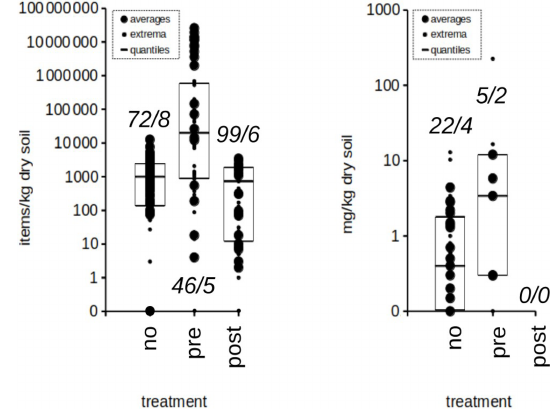
Figure 4. Quantities of MPs measured after density fractionation without the treatment of soil organic matter (SOM; no), with pre- treatment (pre) and post-treatment (post). Big dots mark median and mean concentrations measured in worldwide field experiments, small dots are the related extreme values or standard deviations, and strong horizontal lines are the overall medians and narrow lines are the 25% and 75% quantile. Italicized numbers indicate the under- lying number of sampling sites or